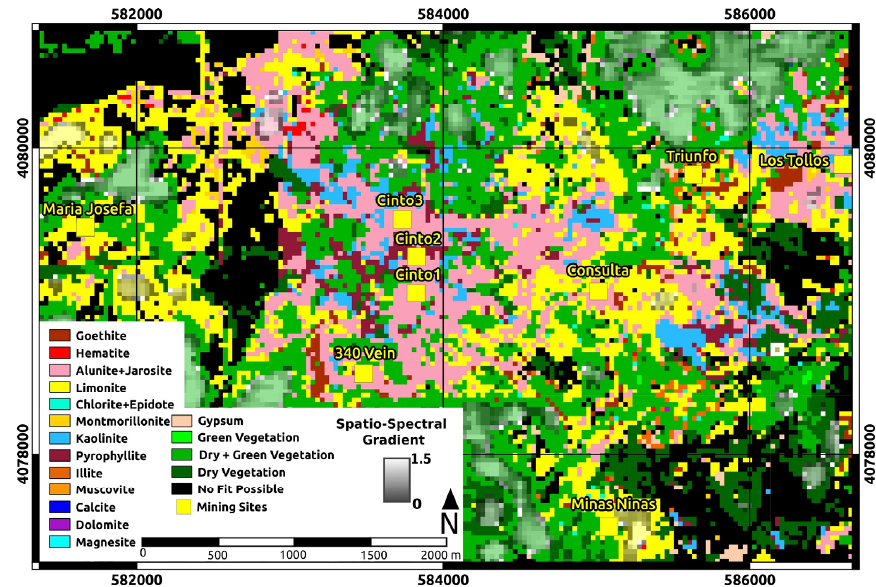
Figure 9. EnGeoMAP 2.0 best fit material map, using sensor dependent absorption depth thresholding, with a semi-transparent overlay of the spatio-spectral gradient and prominent gradient edge pixel (non-transparent rim pixel around the gradient patches).